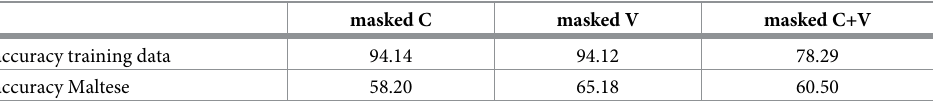
Table 3. Global accuracies of the three NDL models trained on Tunisian and Italian nouns with masked C, masked V or masked CV as cues; tested on Maltese nouns. masked